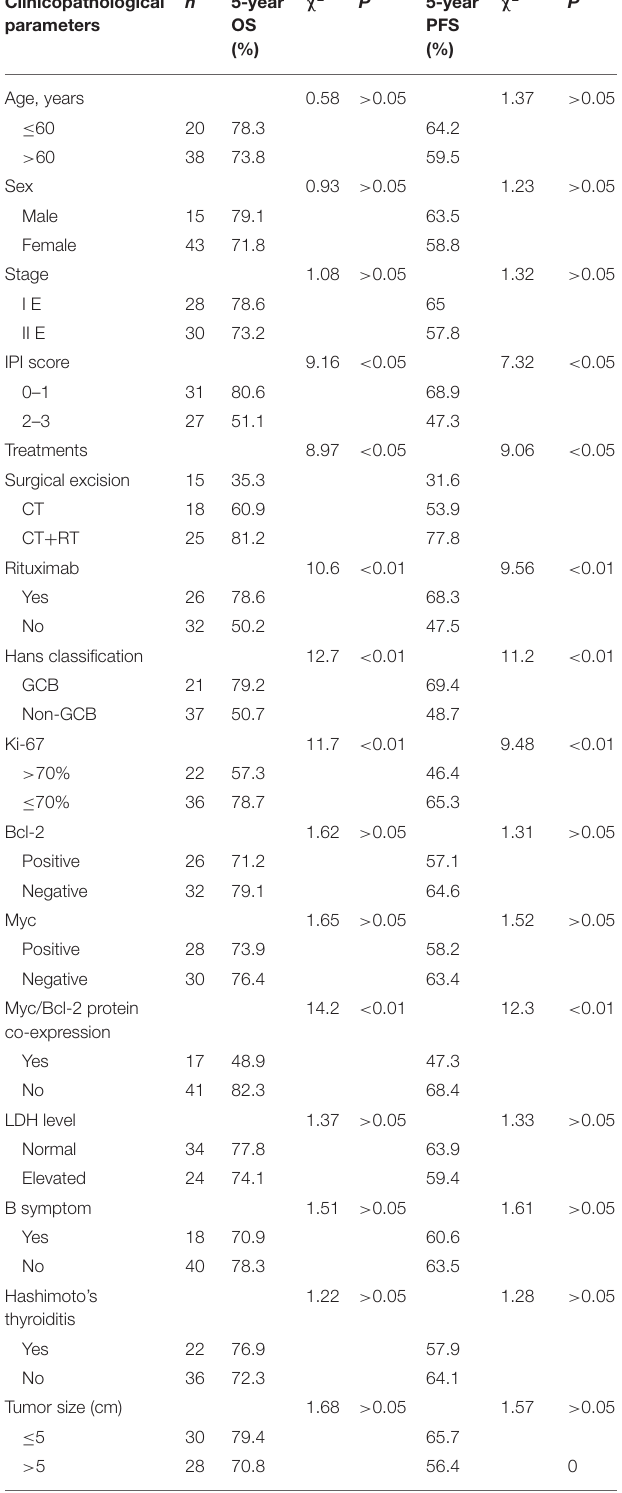
TABLE 1 | Univariate analysis affecting OS and PFS of patients with primary thyroid